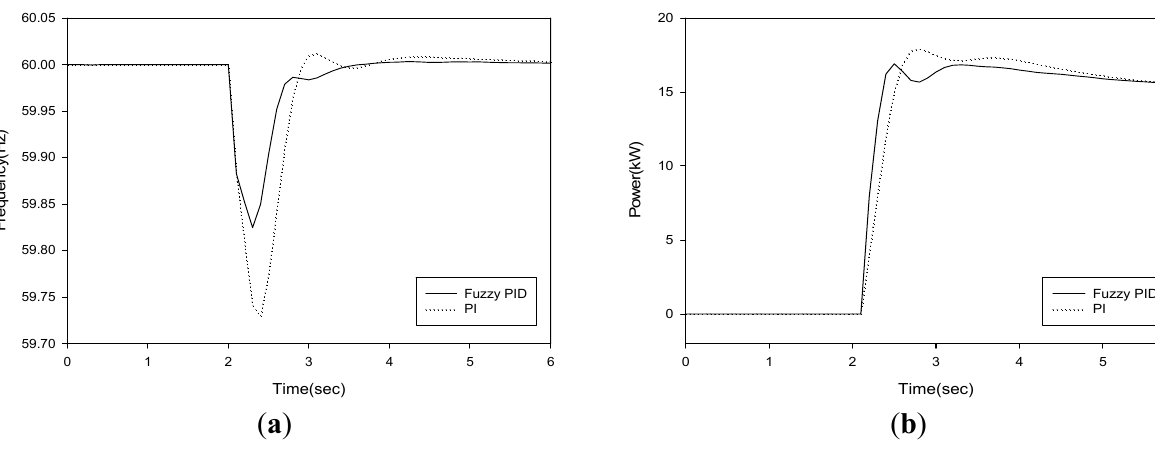
Figure 15. Simulation results in Case A: ( a ) Frequency deviation; ( b ) Power output of the ESS.